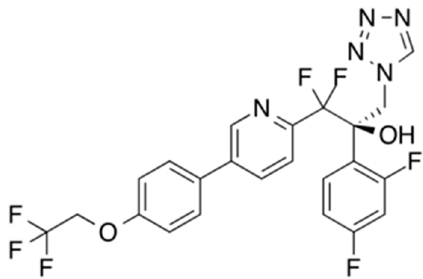
Figure 1. Chemical structure of VT-1161.